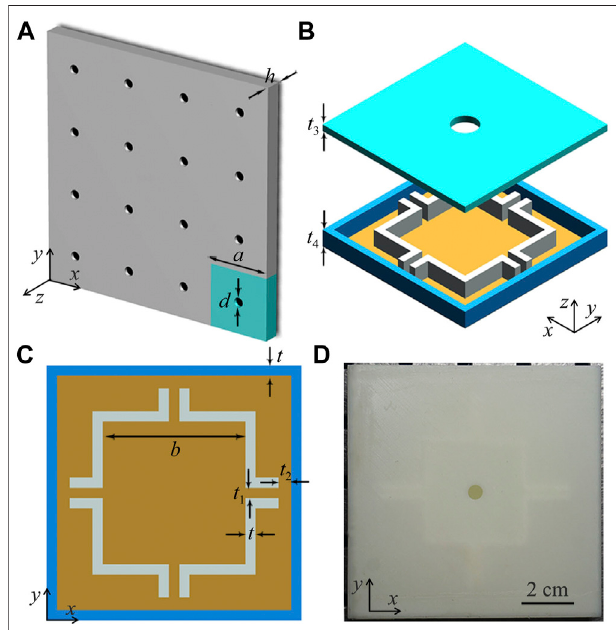
FIGURE 1 | (A) Structure of acoustic metasurface-based absorber composedofperiodicsquareunits. (B) 3Dstructureoftheunitconstructedby an upper surface panel with a central circular hole and a multiple-cavity structureonthebottom. (C) 2Dstructureofthemultiple-cavitystructure. (D) Top view of paragraph of the